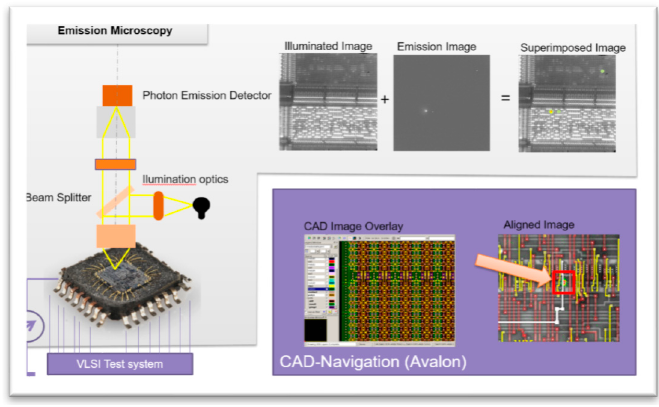
Figure 6. Photon emission interaction with Avalon HotSpot Analyzer.